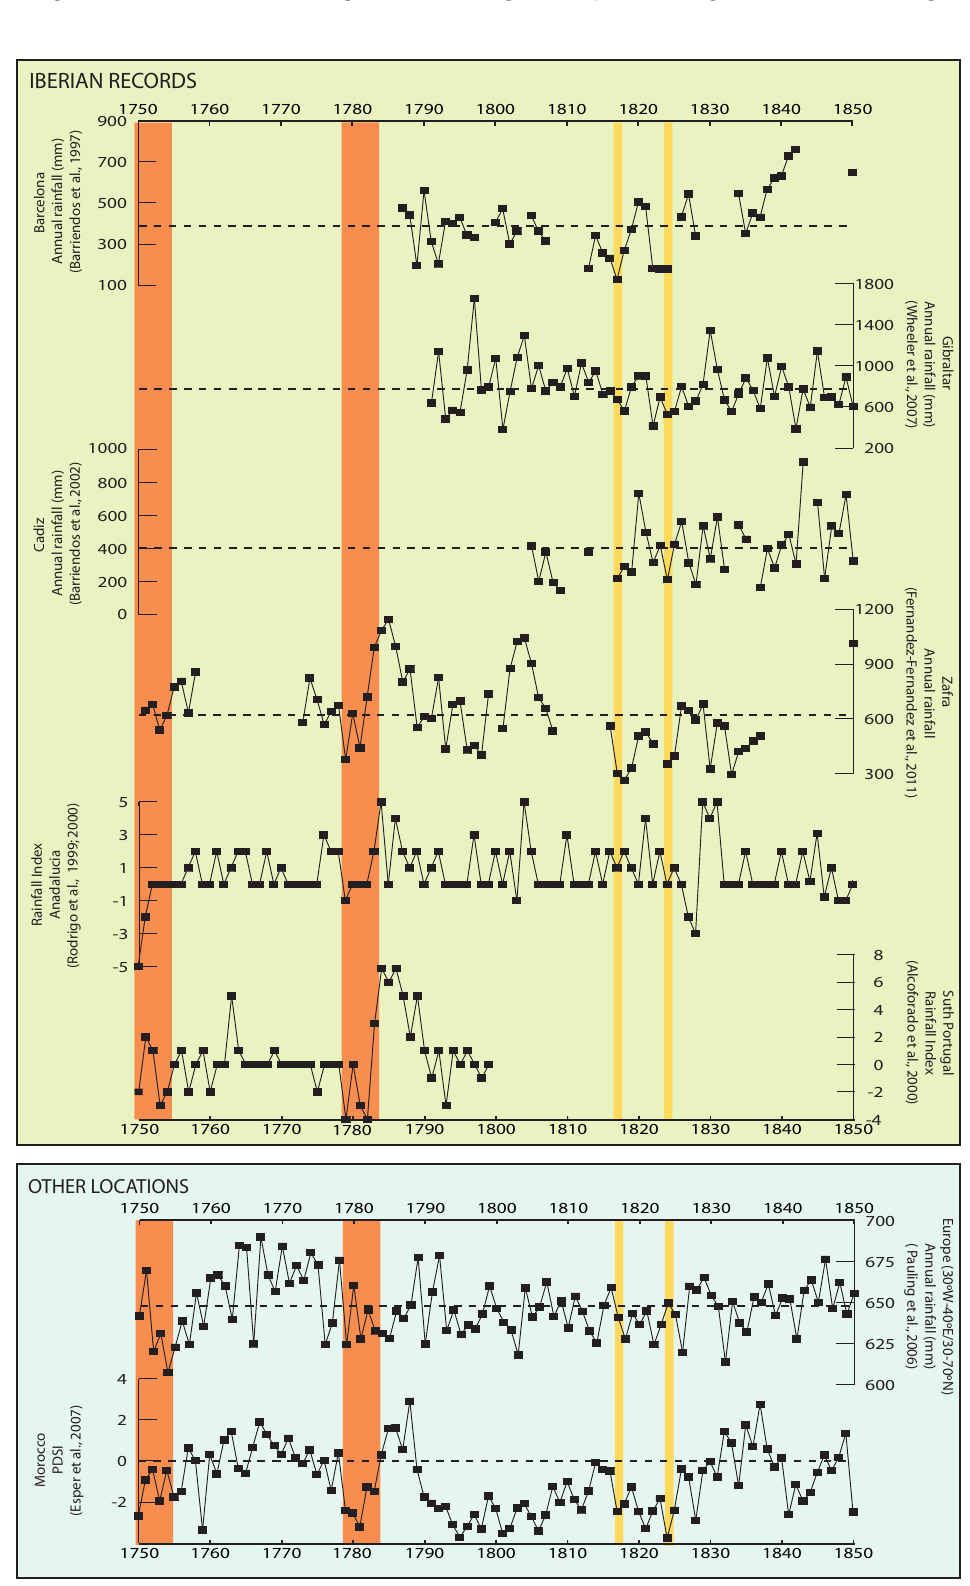
Fig. 9. Evolution of some instrumental, observational and proxy precipitation series in the Iberian Peninsula (upper panel) and outside the Iberian Peninsula (lower